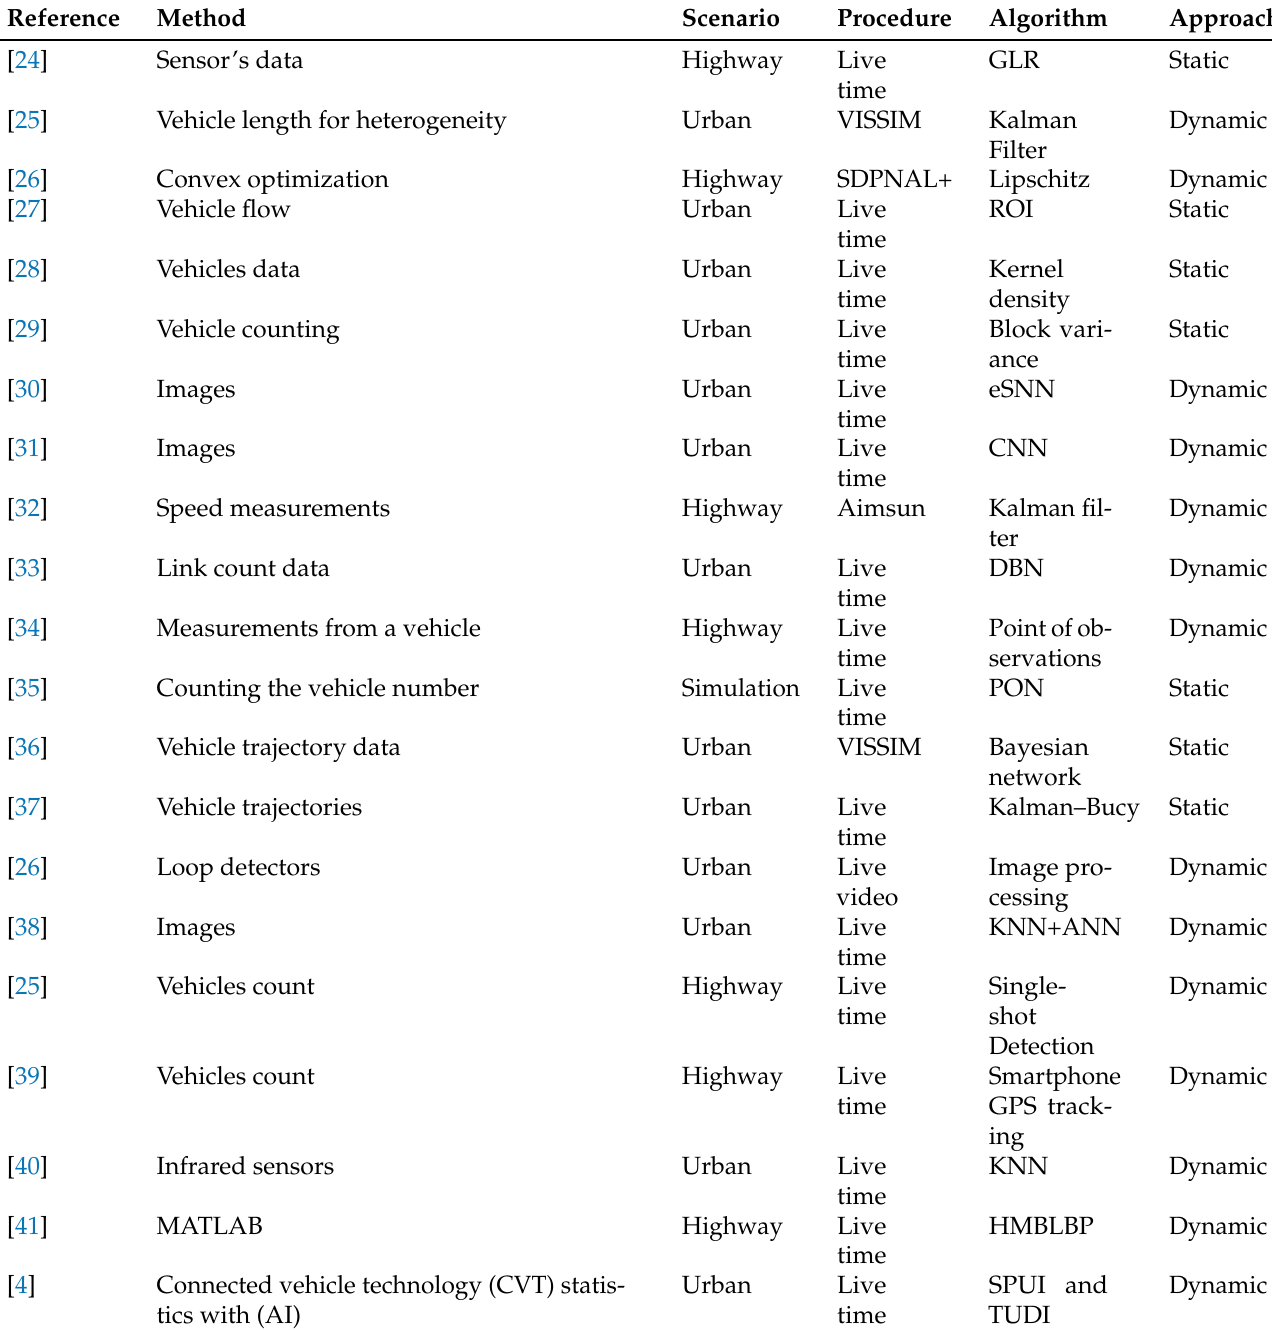
Table 3. Assessment of TDE